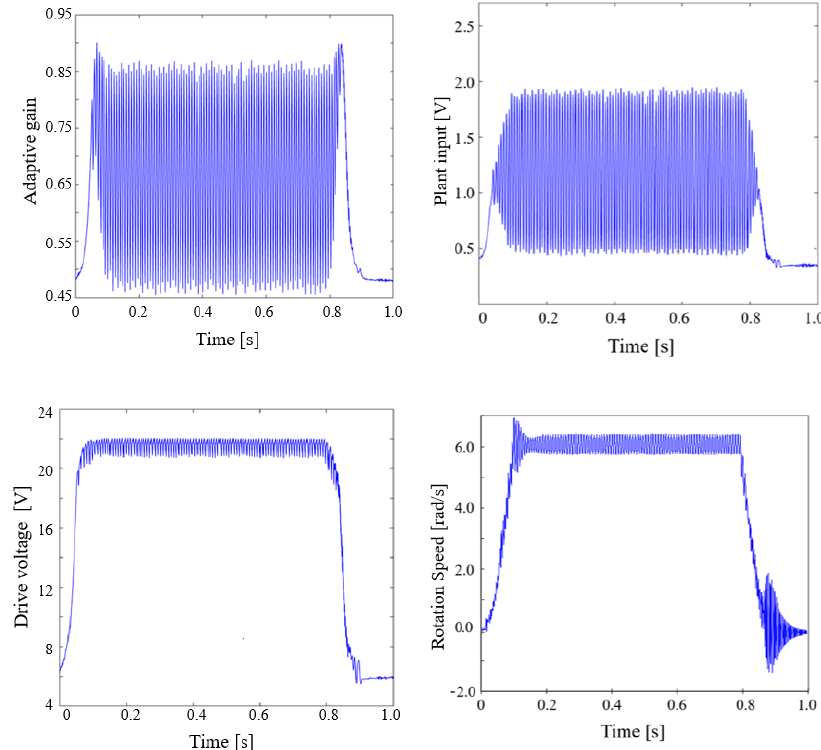
Figure 11. Responses of the proposed method with the I regulator ( Γ P = 0, Γ I = 500).